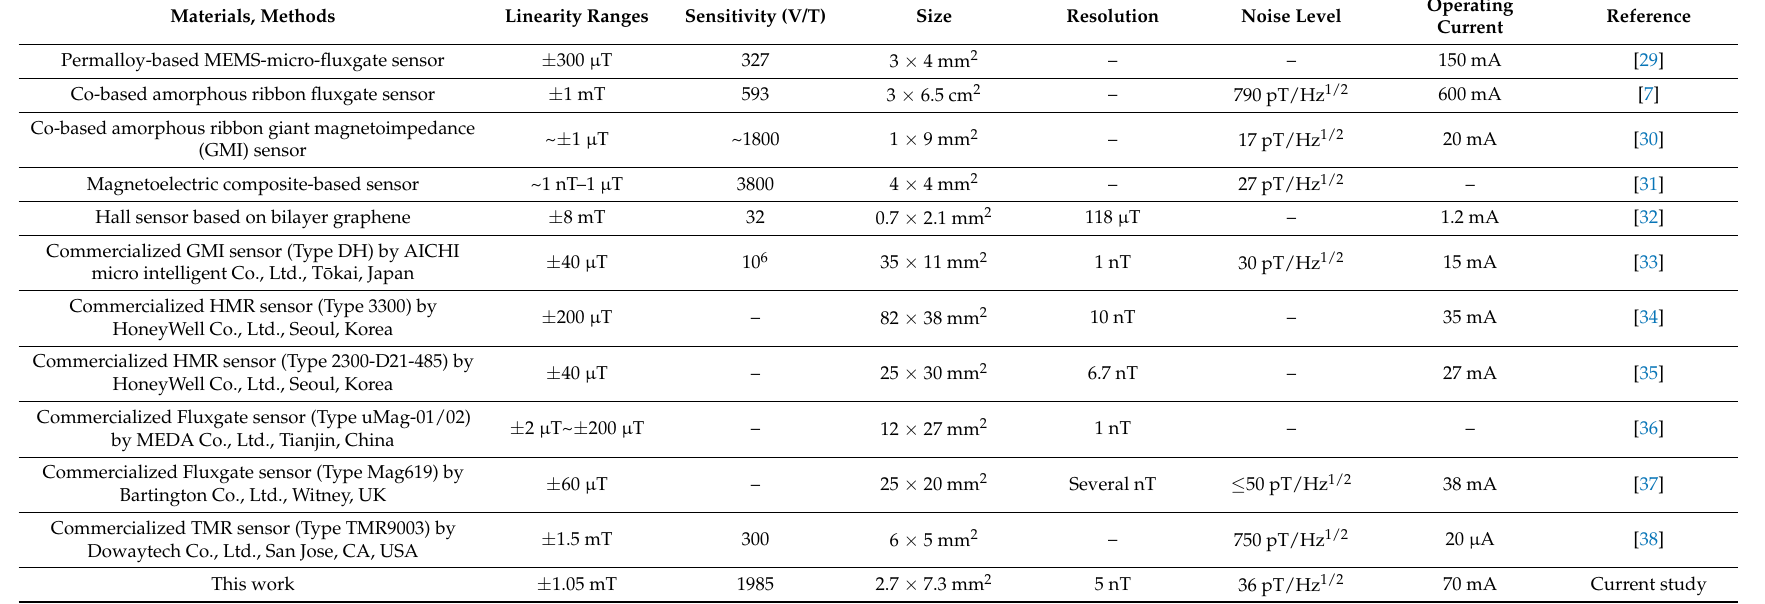
Table 1. Comparison of recently reported magnetic